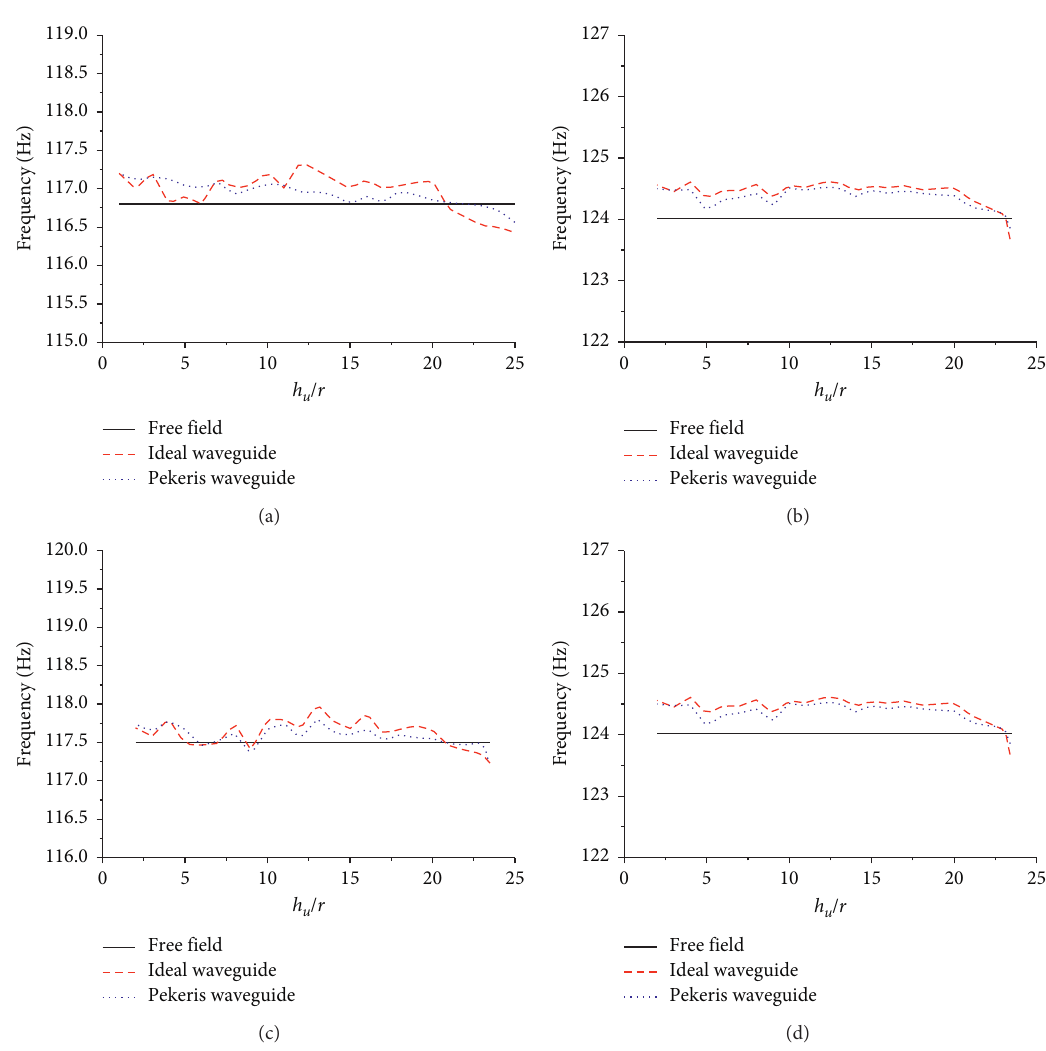
Figure 6: Modal frequency curves with different submerge depths. (a) (9,7). (b) (9,5). (c) (7,8). (d)